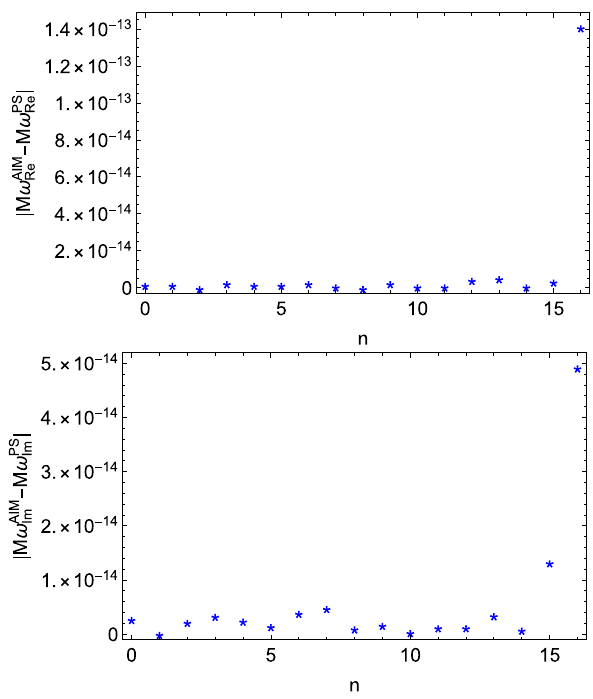
Fig. 3 The figure shows the difference between the frequencies obtained by means of the AIM and the ones obtained from the pseudo- spectral method, in logarithmic scale, as a function of n for the spin s = 0 perturbation field. The top panel is for the real part of the fre-